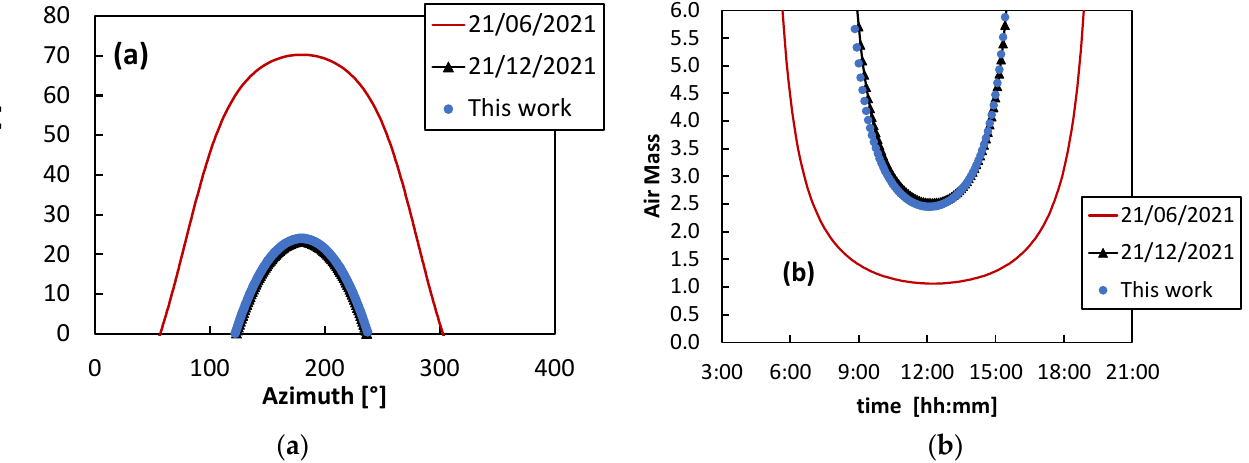
Figure 2. ( a ) Sun elevation θ as a function of the azimuth angle calculated for the test site (Siena, Italy) in the case of June and December solstices and for the measurement campaign described in this work. ( b ) Corresponding air mass values calculated from elevation angle as a function of time.